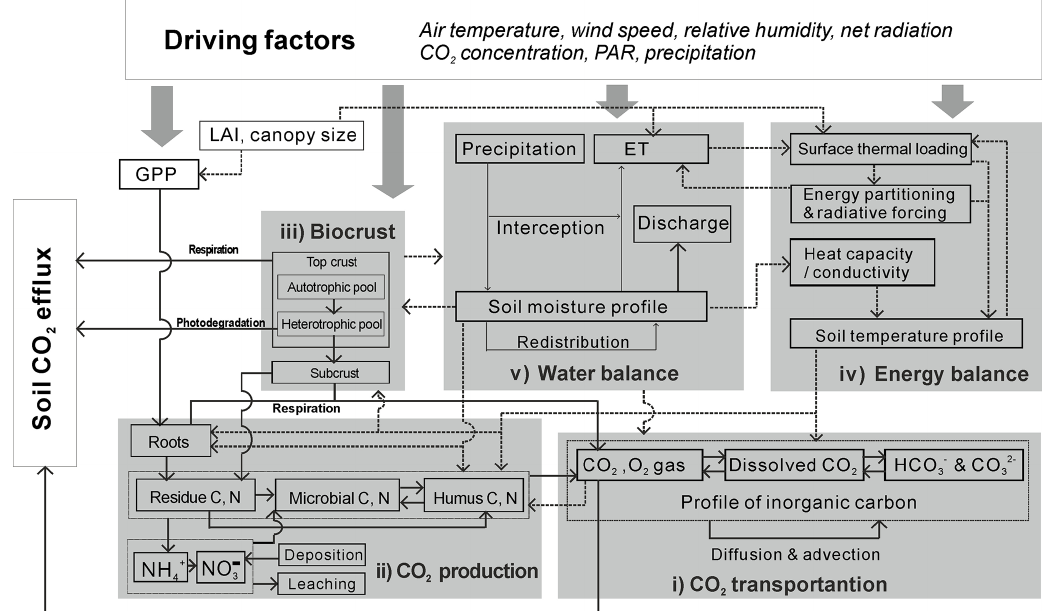
Figure 2. Conceptual framework of process-based modelling. Solid arrows represent flows of masses and dashed arrows represent flows of